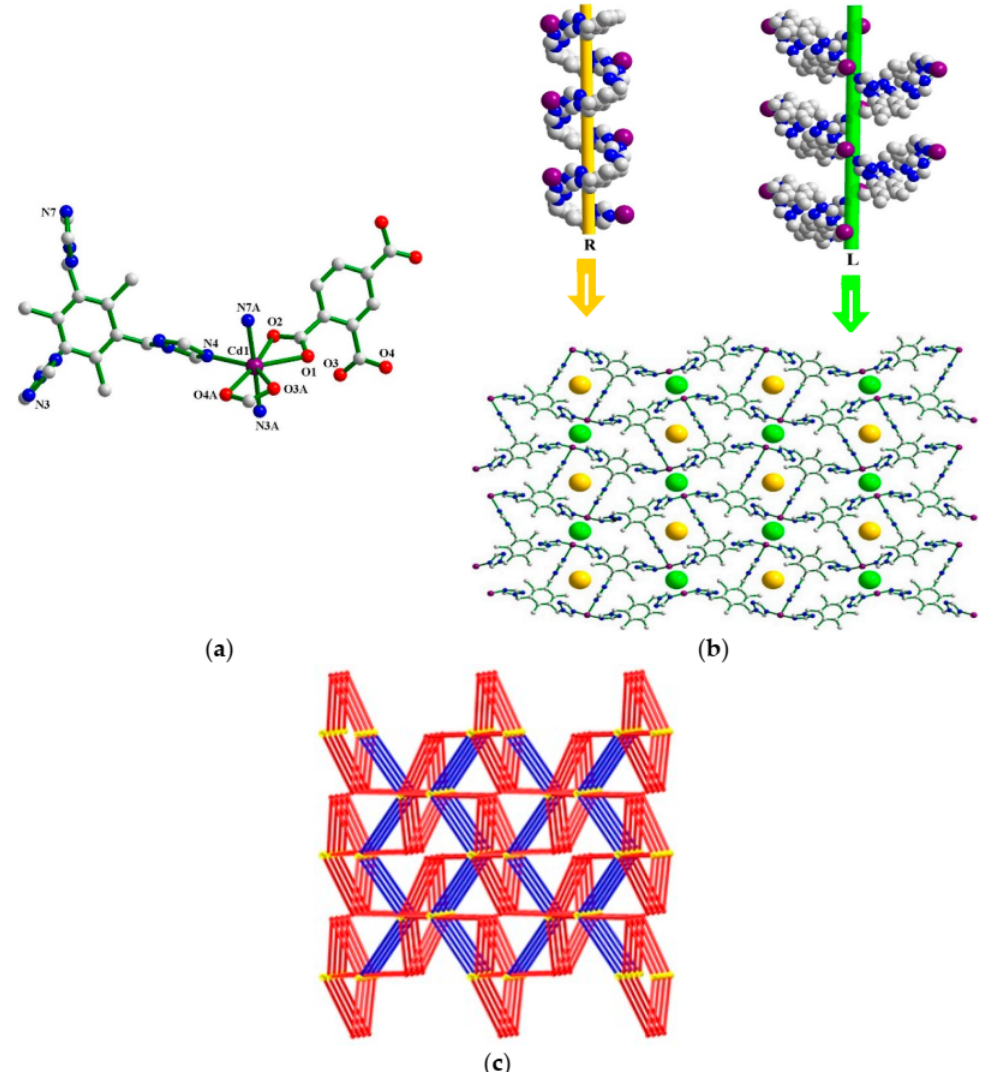
Figure 1. ( a ) Coordination environment of Cd(II) ion in 1 . ( b ) The 3D Cd(II)/tttmb architecture extended by alternately left- and right-handed helical chains. ( c ) Schematic representation of 1 with (5 3 · 6 · 7 3 · 8 3 )(5 2 · 7) topology. Yellow node: Cd(II) ion; red stick: tttmb; blue stick: Hbtc 2 −